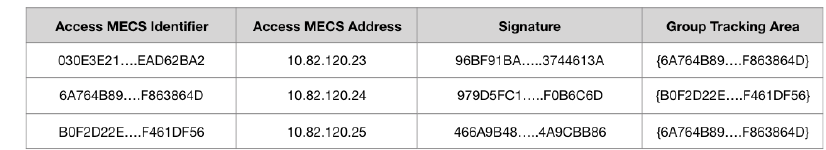
Figure 3. An example of EML list generated by the EMO.